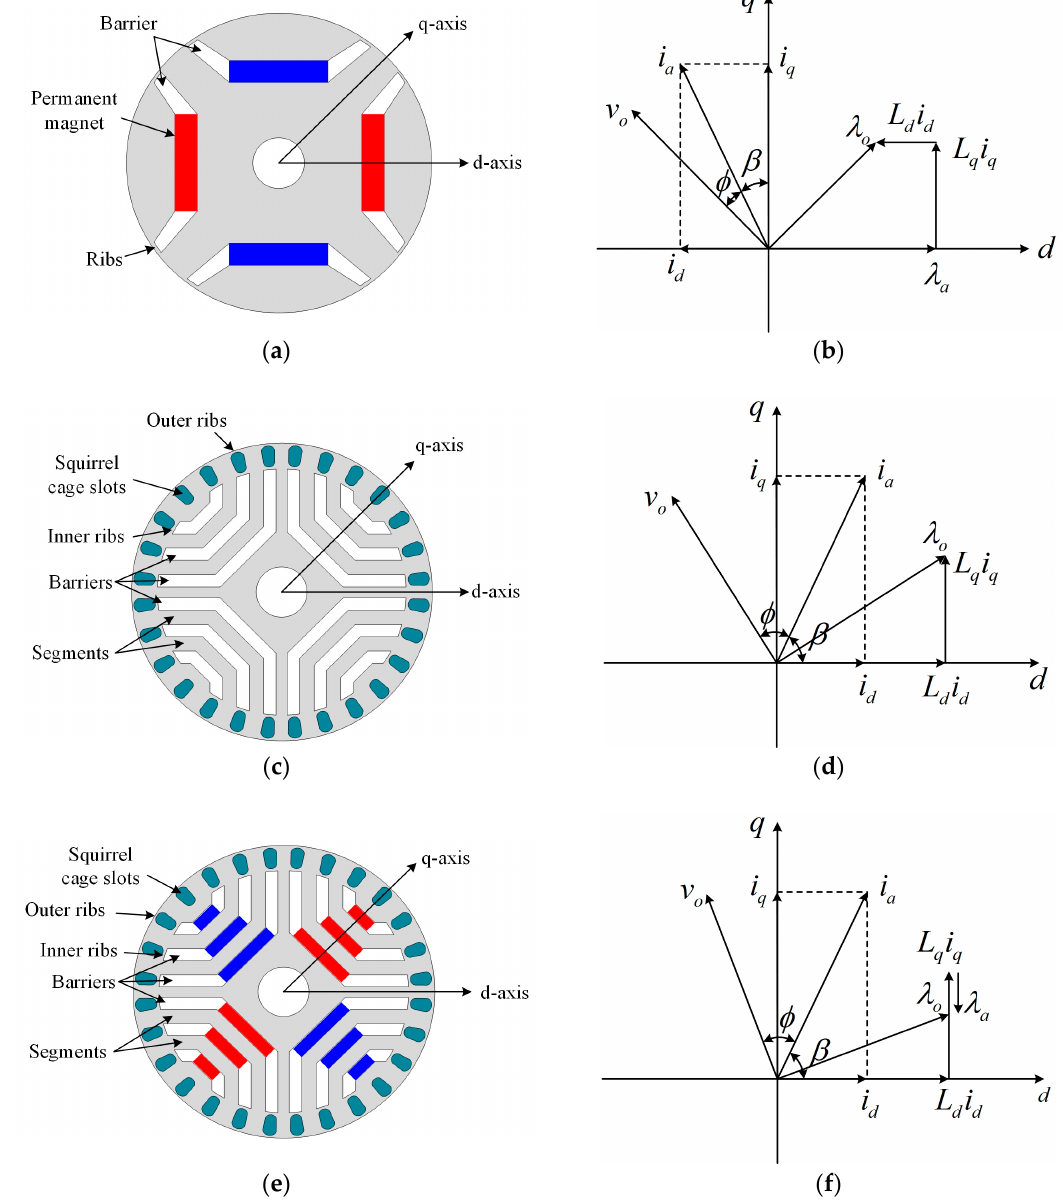
Figure 1. Structure of a line-start synchronous reluctance motor (LS-SynRM) and vector diagram ( a ) structure of an interior permanent magnet synchronous motor (IPMSM) ( b ) vector diagram of an IPMSM, ( c ) structure of a LS-SynRM, ( d ) vector diagram of a LS-SynRM, ( e ) structure of a line-start permanent magnet assistance synchronous reluctance motor (LS-PMA-SynRM), ( f ) vector diagram of a LS-PMA-SynRM .